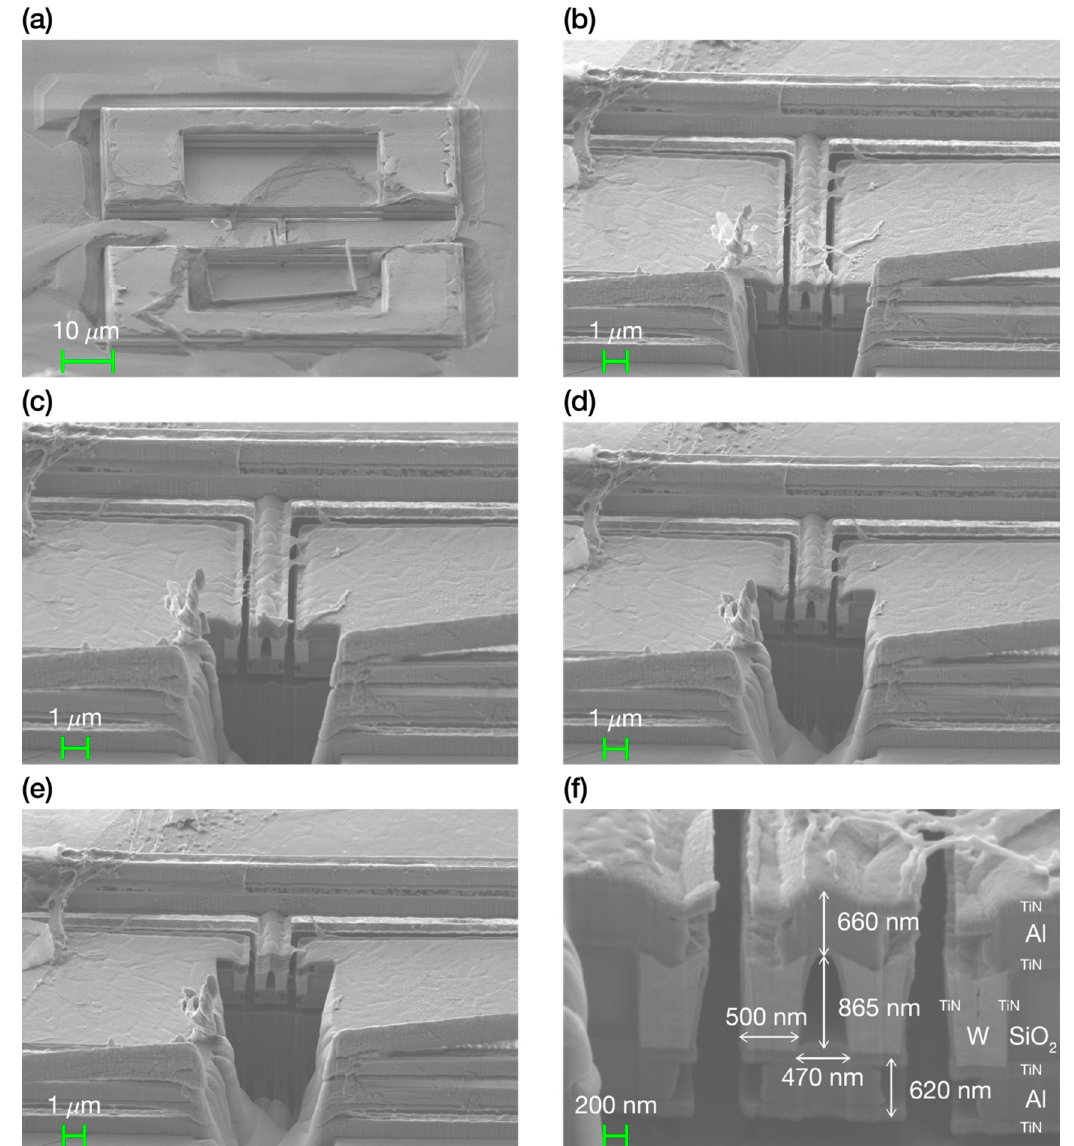
Figure 5. SEM images of a fabricated suspended microbridge resonator 10 μ m long and 1.45 μ m wide, with a built-in nanochannel of 450 nm, before and after some FIB cuts. ( a ) General view of the suspended nanochannel bridge resonator before making any FIB cut. ( b ) SEM image showing the interior of the nanochannel after a first FIB cut. We can easily appreciate that the nanochannel is empty for a quarter of its length. ( c ) SEM image showing the interior of the nanochannel after a second FIB cut. The nanochannel is empty for almost half its length. ( d ) SEM image showing the interior of the nanochannel after a third FIB cut. We see that the nanochannel is empty for more than half its length. Thus, it will be completely empty since the BHF bath etches silicon dioxide from both extremes. ( e ) SEM image showing the interior of the nanochannel after a fourth FIB cut. From the sequence of FIB cuts, we see that the nanochannel is completely empty from access hole to access hole. ( f ) SEM image showing a zoom in of the nanochannel. The cross-section image shows that the nanochannel has a width in the base of 470 nm and a height of 865 nm.